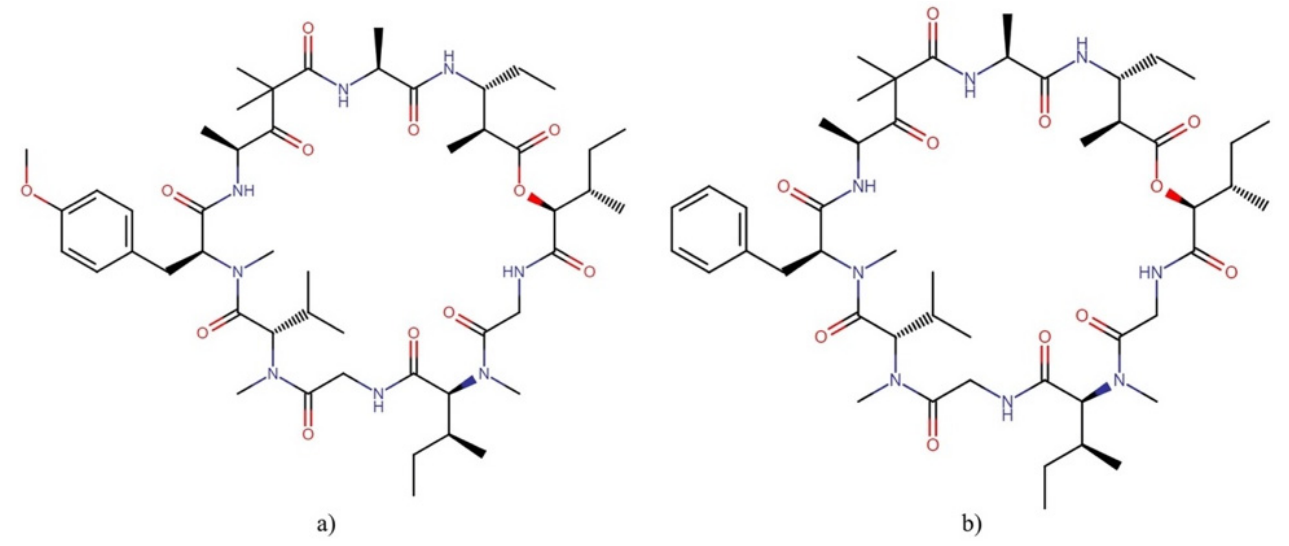
Figure 18. Chemical structures of ( a ) majusculamide C and ( b ) desmethoxymajusculamide C. Majusculamides C and D exhibited cytotoxic activity against several cell lines, with IC 50 values ranging from 0.32 nM to 1.3 µM [122,123]. In addition, desmethoxymajusculamide C exhibited potent cytotoxicity against various cancer cell lines by disrupting the cytoskeletal actin microfilament networks, the human colon carcinoma cell line HCT-116 being the most sensitive, with an IC 50 value of 20 nM (Table 10 ) [124].